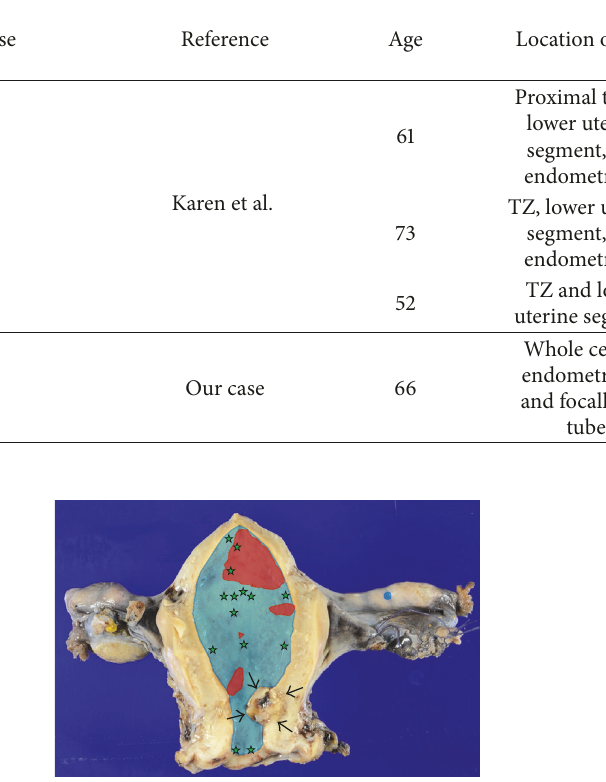
Figure 6: Distribution of epithelial lesions. Blue: gAIS. Red: simple gastric metaplasia. Green star: SMILE. The tubal lesion is a skip lesion. Cervical leiomyosarcoma is indicated by